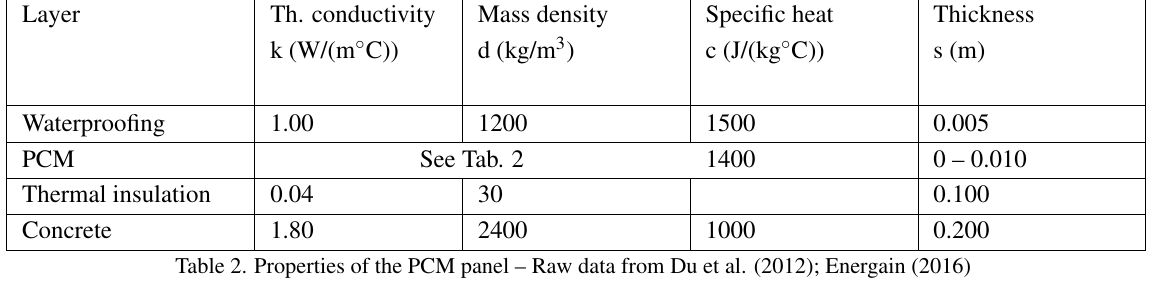
Table 2. Properties of the PCM panel – Raw data from Du et al. (2012); Energain (2016)